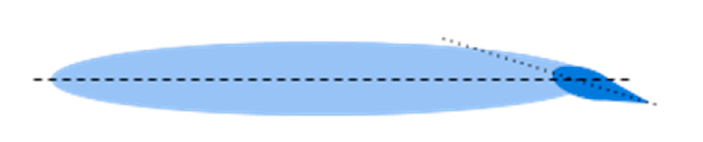
Figure 1. Profile of keel with trim